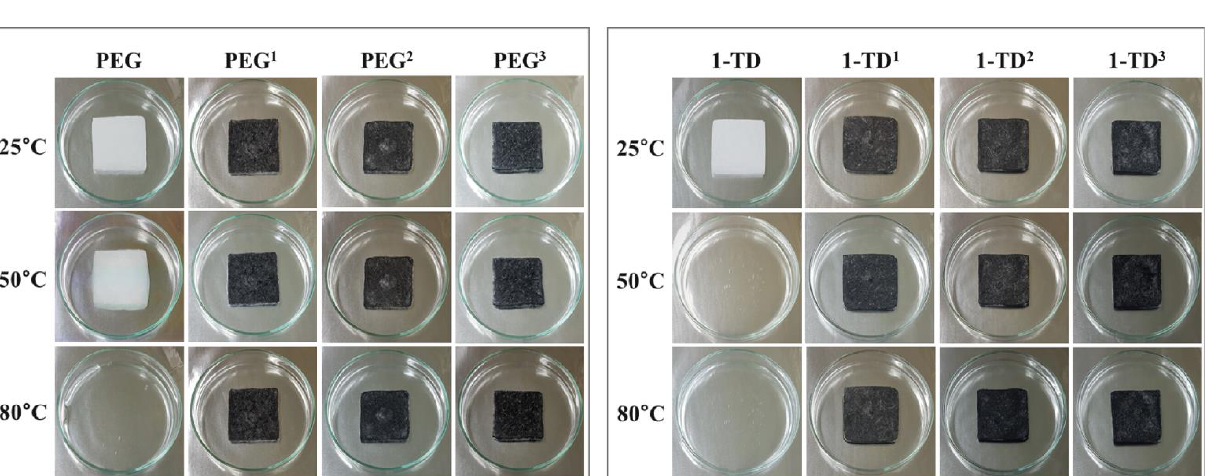
Table 4. DSC results of pure PEG and 1-TD composites.